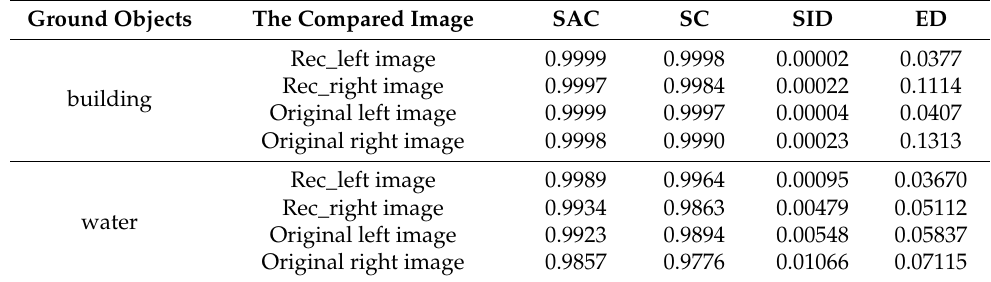
Figure 11. Comparison of typical spectral curves before and after image mosaicking for the urban scape area: the spectral curves of objects of ( a ) building; ( b ) water; ( c ) soil; ( d ) farmland; ( e ) road are represented in five colors, the sources of the spectral curves are shown in ( f ) using the texts in the corresponding colors, where the original_left means the original left image, original_right means the original right image; mosaic means the mosaicked image; Rec_left means the geo-registered left image, Rec_right means the geo-registered right image. Table 7. Evaluation of similarity of spectral curves of different ground objects in the overlapped area before and after image mosaicking (urban